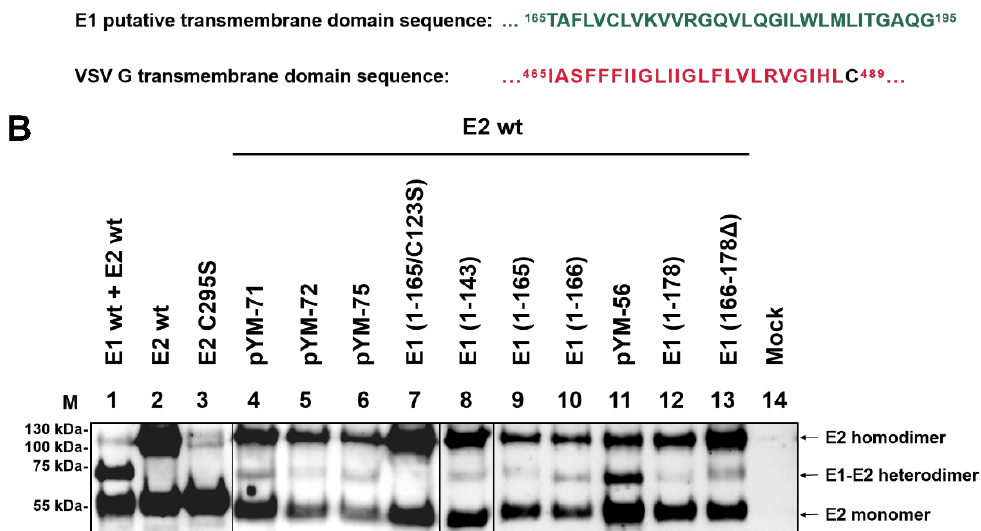
Figure 4. Heterodimer formation analysis. ( A ) Schematic representation of the HA-E1 wild type and Carboxy-terminally truncated E1 constructs used in this section. Cysteine residues C123 and C171 are presented as white lines in the green bar representing the E1 sequence. Further constructs shown here encode HA-E1 with the TM domain or parts thereof replaced by sequences from the TMD of VSV. Below the schemes, the amino acid sequences of the chimeric TMDs are given in the one letter code (see also [23]). ( B ) The given Carboxy-terminally truncated E1 expression plasmids were co-transfected with a plasmid coding for E2 wt into RK-13 cells. Co-expression products were analyzed via nonreducing SDS-PAGE and Western blot using mAb α-E2 (WB214) for the detection of the E1/E2 heterodimer and E2 monomer/homodimer. A file is provided in the Supplementary Materials with the original Western blot results to demonstrate that the two parts were derived from equivalent gels and the mock control was run on one of these gels.